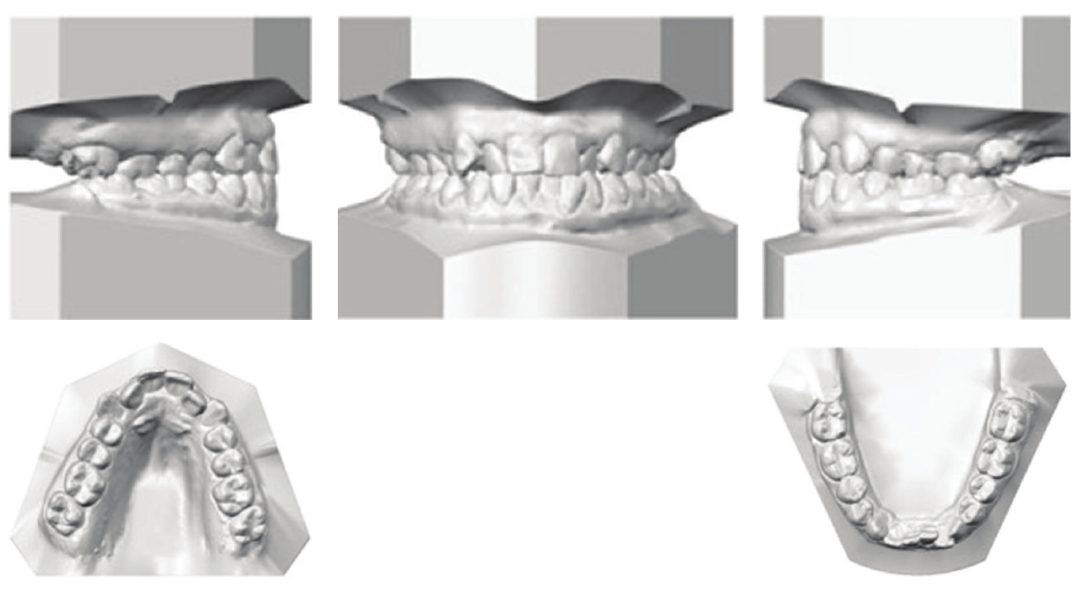
Figure 2: Initial